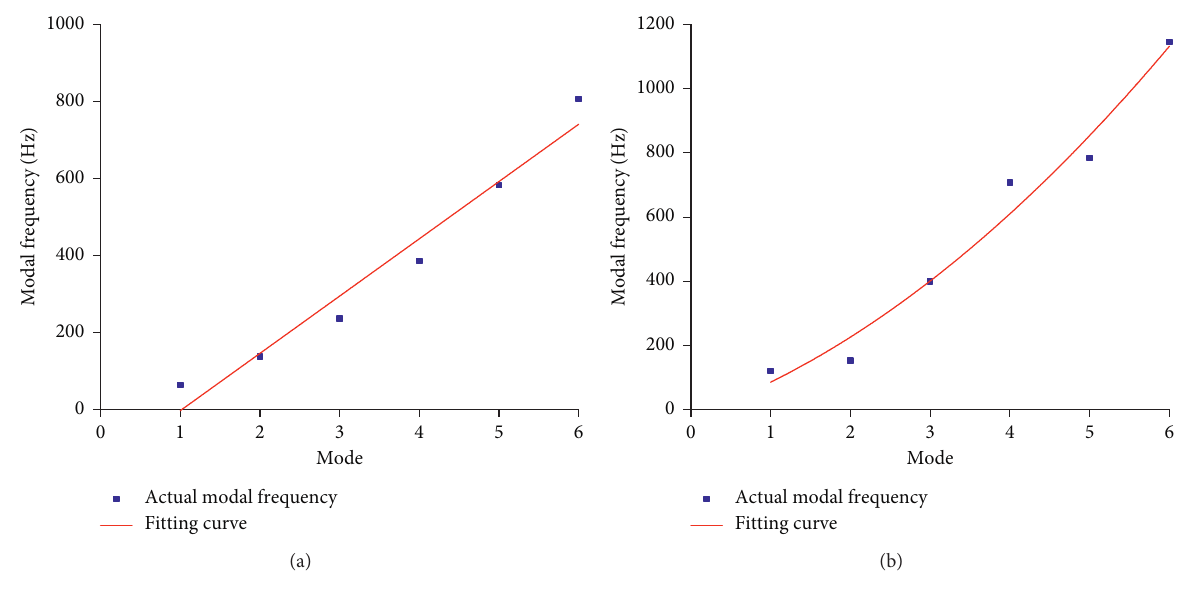
Figure 7: Modal frequency: (a) vertical and (b)